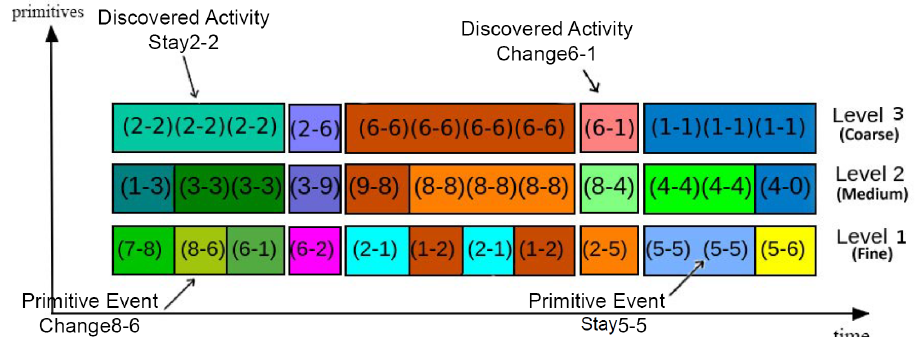
Figure 3. A sample video encoded with primitive events and discovered activities in three resolution